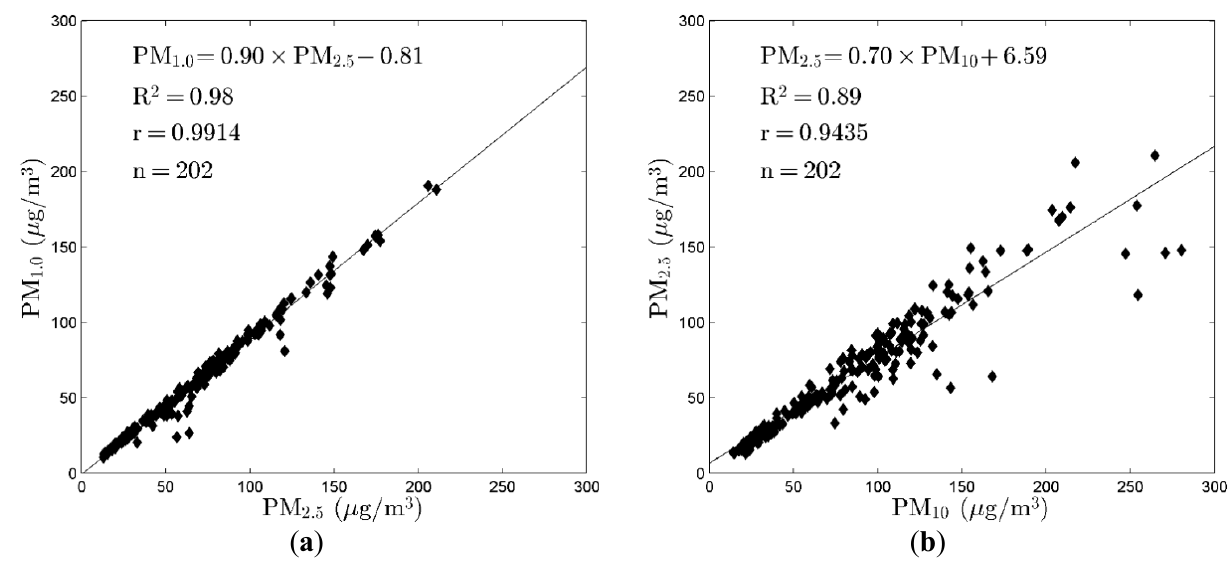
Figure 4. Correlation between mass concentration of PM 1 and PM 2.5 ( a ), PM 2.5 , and PM 10 ( b